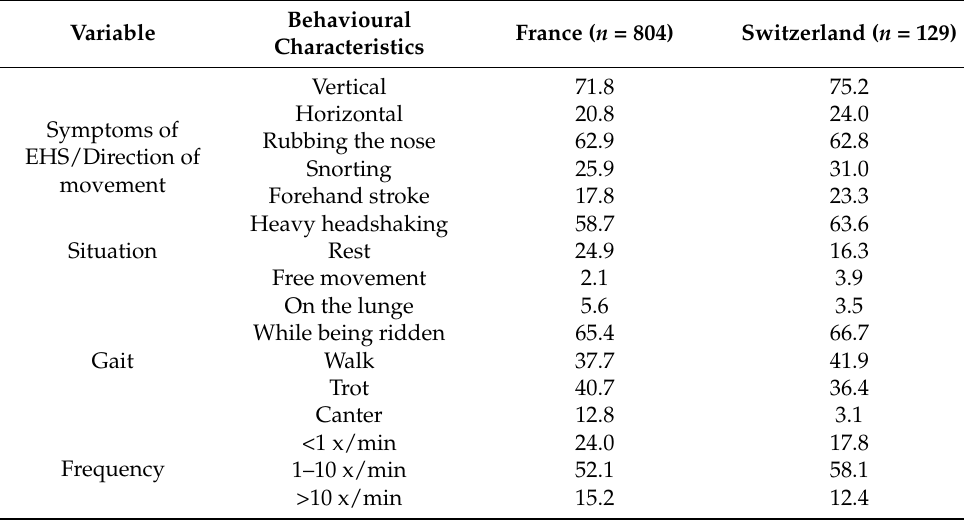
Table 3. Behavioural characteristics of equine headshaking syndrome (EHS) given in percent (direc- tion of movement, situation, gait, and